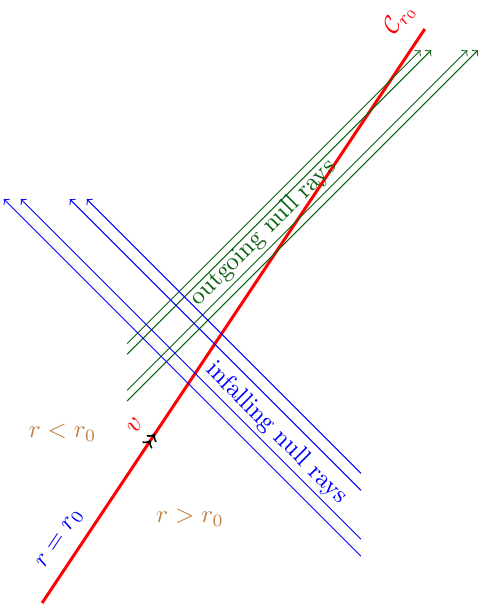
Figure 1 . Depiction of a causal boundary at an arbitrary r = r 0 . We want to formulate physics in the ‘outside’ r ≥ r region and excise the r < r part. Unlike the null boundary case of [1], here 0 0 we can have both infalling and outgoing null rays passing through the causal boundary. In our setting we allow for ‘local boosts’ which encode fluctuations of the causal boundary C , this adds r 0 one more surface charge compared to the null boundary case. For the 2 d and 3 d cases we consider here, however, we do not have bulk modes and hence there are no infalling or outgoing null